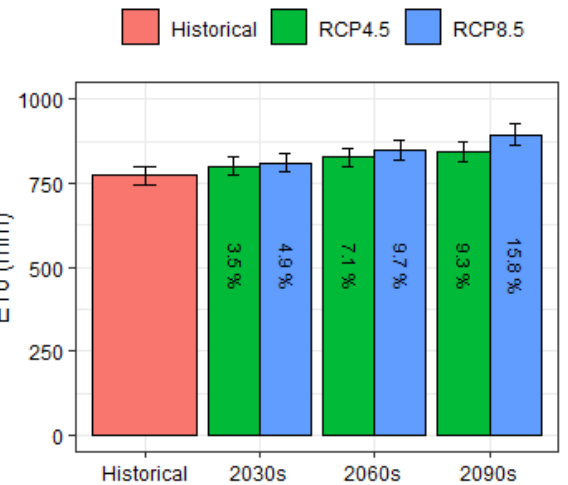
Figure 5. Historical and projected average total reference crop evapotranspiration (ETo) for the potato fixed cycle length. Percent numbers correspond to change with respect to the historical period.